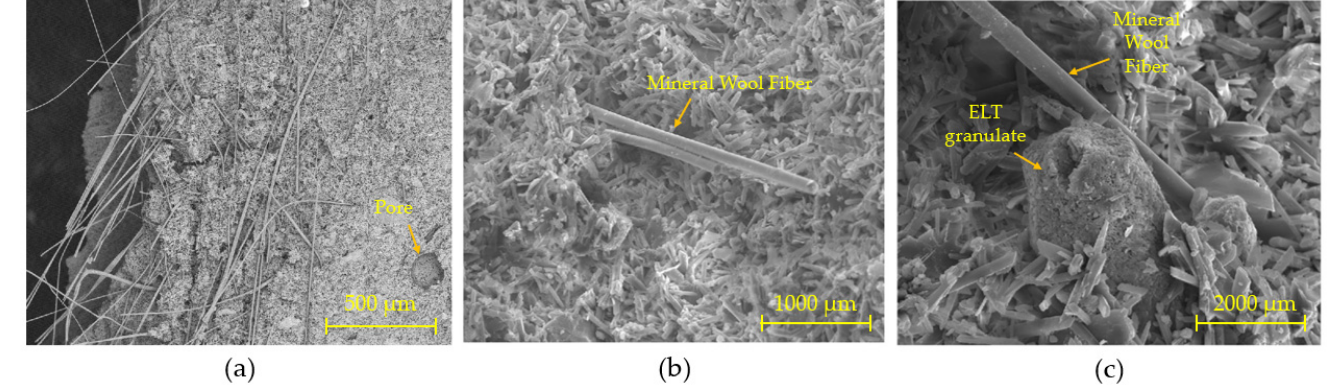
Figure 10. Secondary electron scanning electron microscopy (SEM) images of sample G0.7–300–RW: ( a ) 500 μ m; ( b ) 1000 μ m; and ( c ) 2000 μ m.